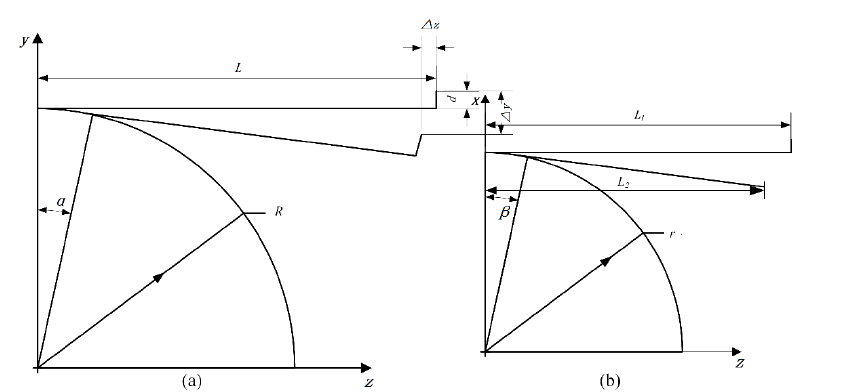
Figure 2. The trajectory of the clamp. ( a ) Horizontal bending. ( b ) vertical bending.